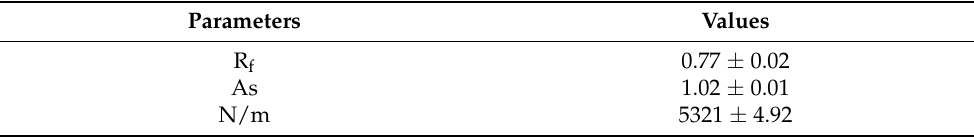
Table 2. System appropriateness parameters of CDN for current protocol (mean ± SD; n = 3).